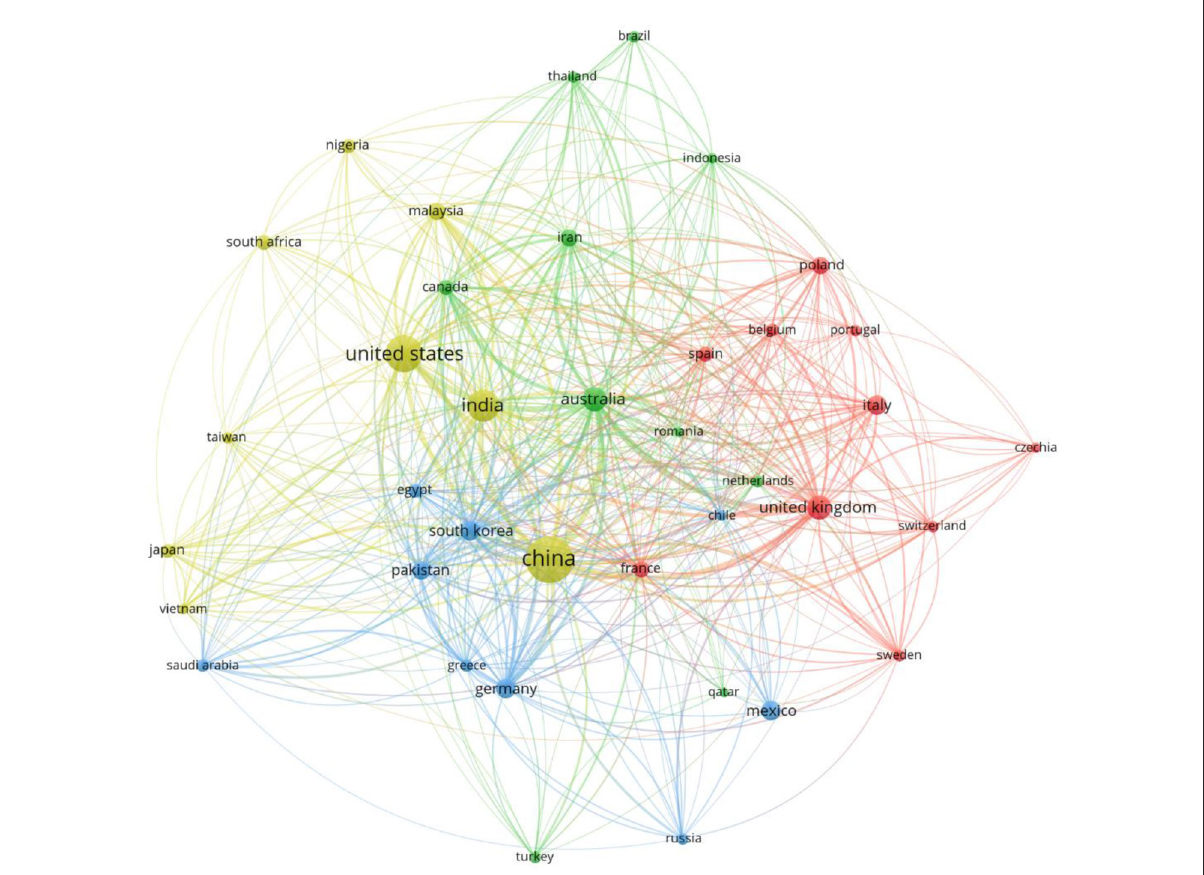
FIGURE2 Countries’ network and density based on relevant documents on phytoremediation of indoor air pollution using bibliographic